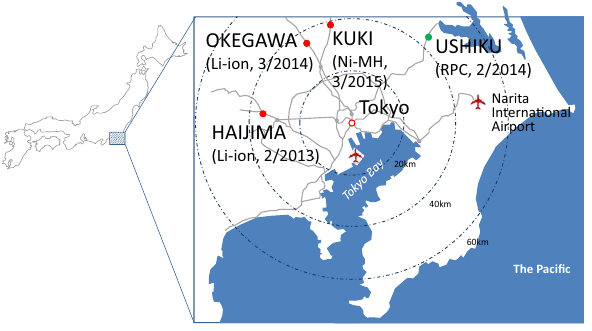
Fig. 10 Location of three energy storage systems in East Japan